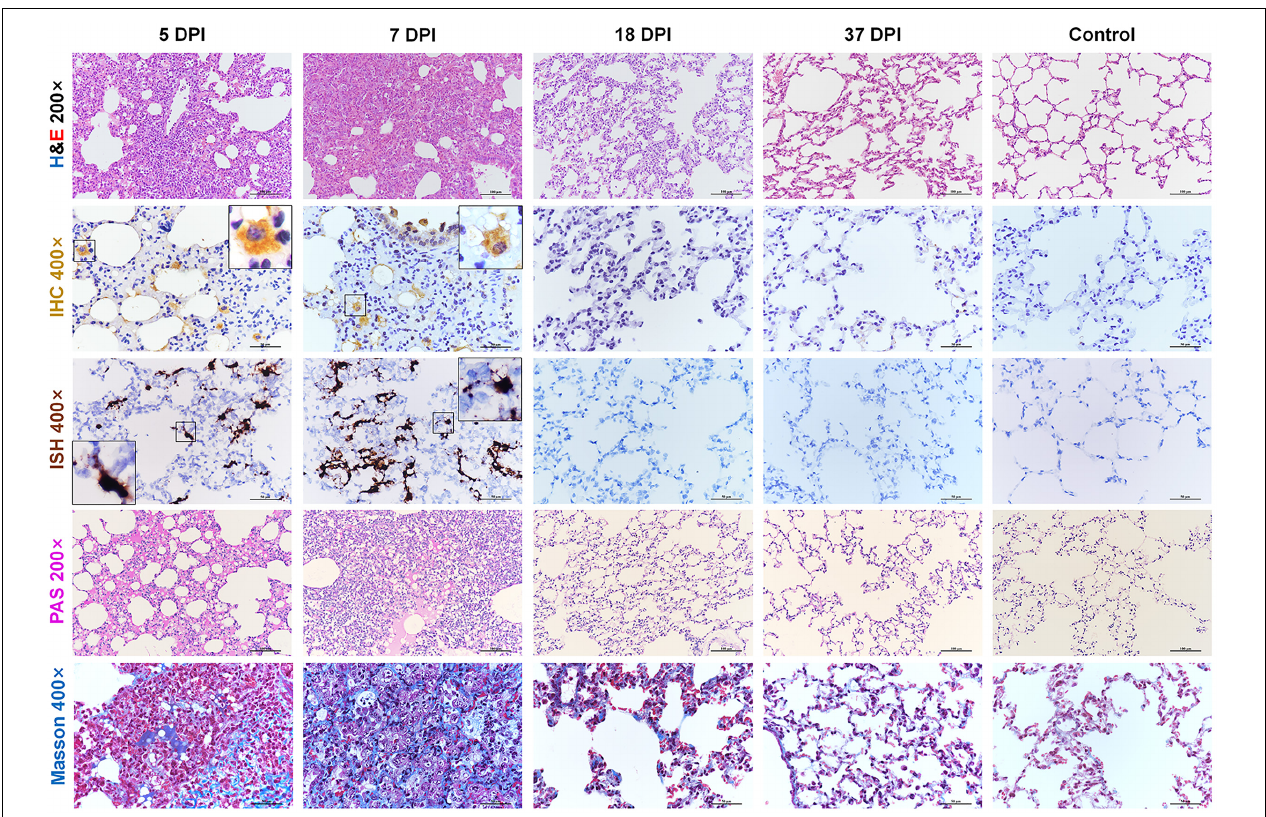
FIGURE 2 | Histopathological changes of the lung at 5, 7, 18, 37 dpi. The viral pathology in the lungs was observed by hematoxylin and eosin (H&E) staining. Viral S protein was examined by immunohistochemistry (IHC). Viral RNA was detected by in situ hybridization (ISH). The black frames in the corners are a magnification of the region in the respective panel of IHC and ISH. Exudation was tested by periodic acid-Schiff (PAS) staining. Collagenous fibers were stained by modified Masson staining. Data are representative of three independent experiments.